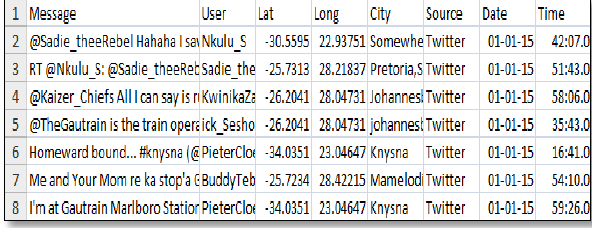
Table 1: Enumerator